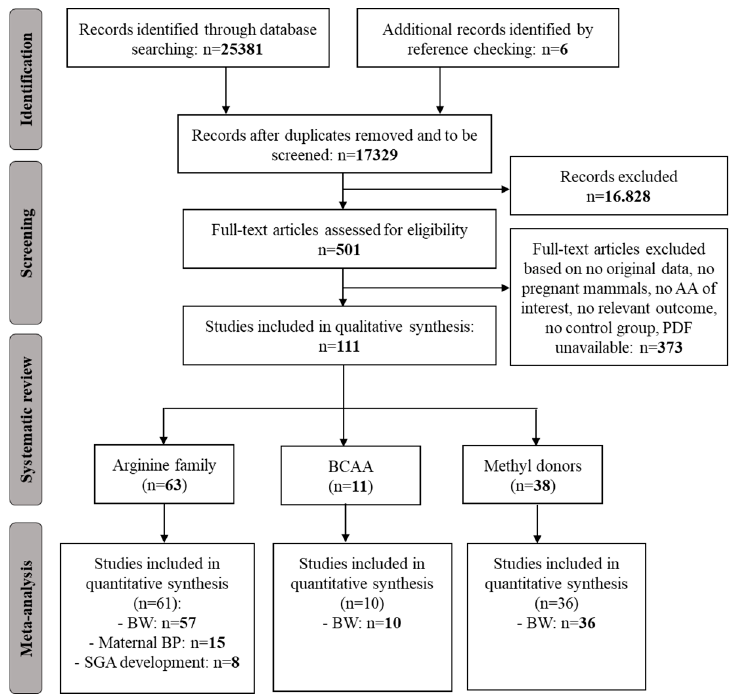
Figure A1. Flow chart of the study selection process: Our search strategy retrieved 17,329 unique hits, of which we included 111 studies reporting on amino acid (AA) supplementation in our systematic review. Of these, 63 studies reported on arginine supplementation, 11 reported on branched-chain amino acids (BCAA) supplementation, and 38 reported on methyl donor supplementation. We pooled data on the e ff ect of arginine supplementation on birth weight (BW) in 57 studies, on maternal blood pressure (BP) in 15 studies, and on small for gestational (SGA) development in risk populations in 8 studies. We were able to pool data on the e ff ect of BCAA on BW in 10 studies and of methyl donor supplementation in 36 studies. Adapted from PRISMA